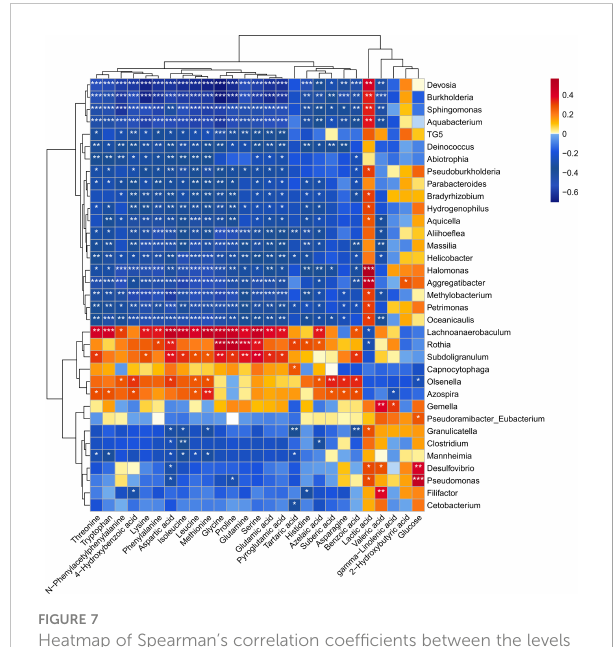
FIGURE 7 Heatmap of Spearman ’ s correlation coef fi cients between the levels of salivary microbial genera and metabolites. Each row represents a differentially expressed genus and each column represents a differentially expressed metabolite. The color of each square represents the degree of association between the genera and the metabolite, with red indicating a positive correlation and blue indicating a negative correlation. Asterisks indicate statistical signi fi cance based on the Spearman correlation. *p < 0.05, **p < 0.01, ***p <